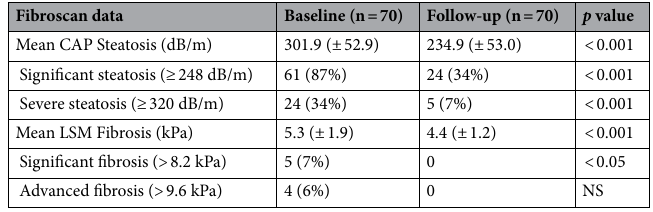
Table 3. Fibroscan results pre and post-surgery.